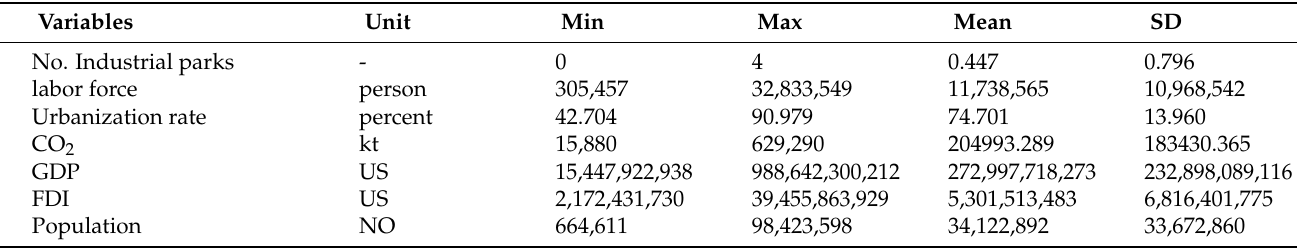
Table 2. Descriptive data